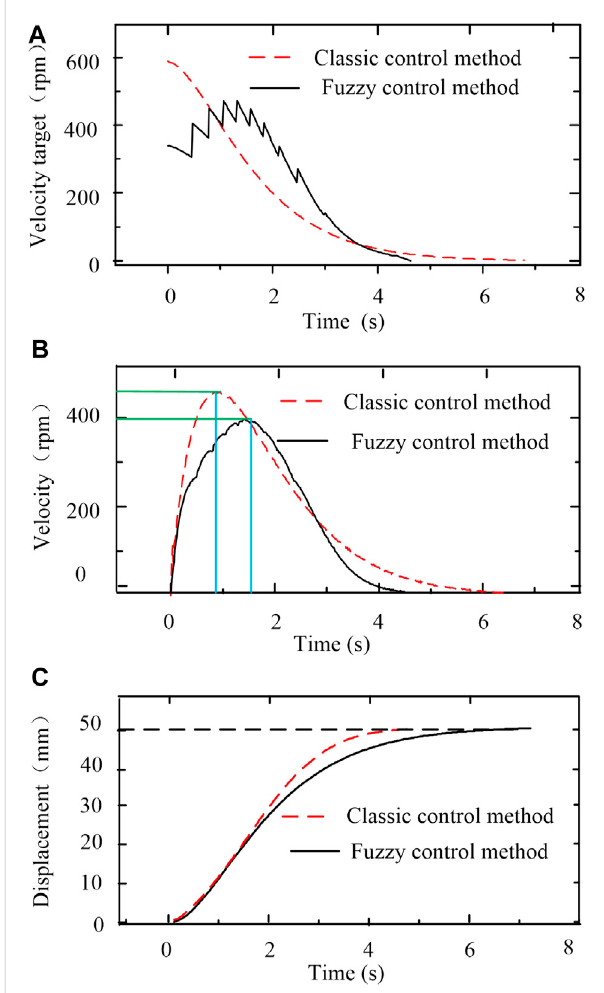
FIGURE 11 The response curves of X motor under 50 mm target displacement are tested experimentally. (A) Shows the comparison curve of the speed target value. (B, C) are the corresponding velocity and displacement curves.